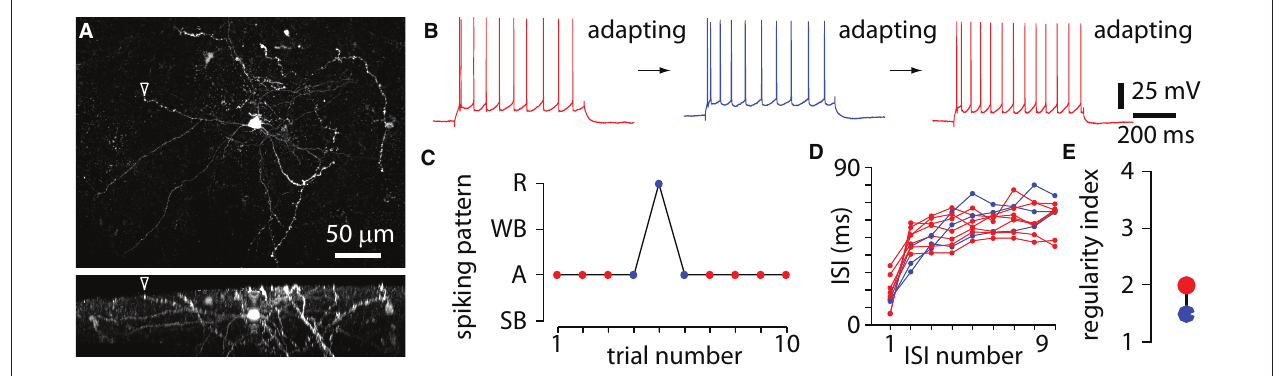
FIGURE 7 | Little temperature-sensitivity of the spiking pattern after loss of apical dendrite. (A) Maximum intensity projections from 2-photon z -stacks, showing a layer 6 pyramidal neuron which is missing much of its apical dendritic tree. The apical dendrite is severed at the surface of the slice (arrowhead). Lower panel shows the same neuron from the side, with the cut branch extending from the soma and rising toward the surface of the slice, where it is cut (arrowhead). (B) Voltage recordings from a layer 6 pyramidal neuron with a severed apical dendrite, showing spiking patterns in a series of trials, during which temperature was changed from 35–37 ◦ C (red) to 24–26 ◦ C